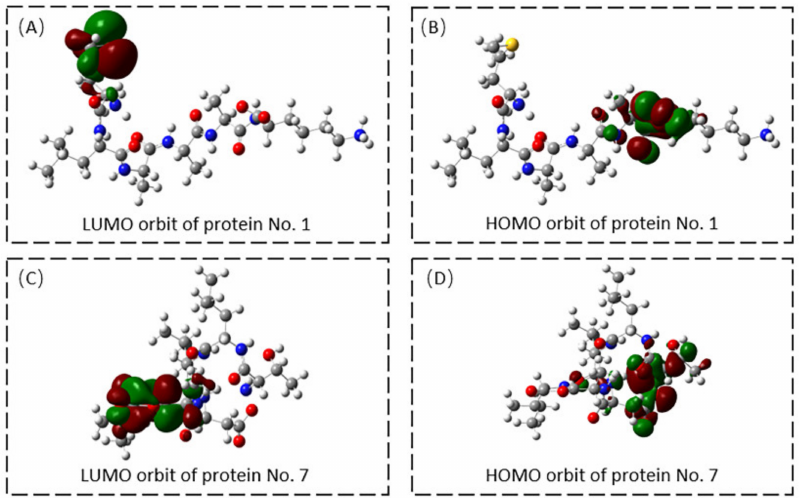
Figure 7. ( A ) LUMO orbit of Protein No. 1; ( B ) HOMO orbit of Protein No. 1; ( C ) LUMO orbit of Protein No. 7; ( D ) HOMO orbit of Protein No.